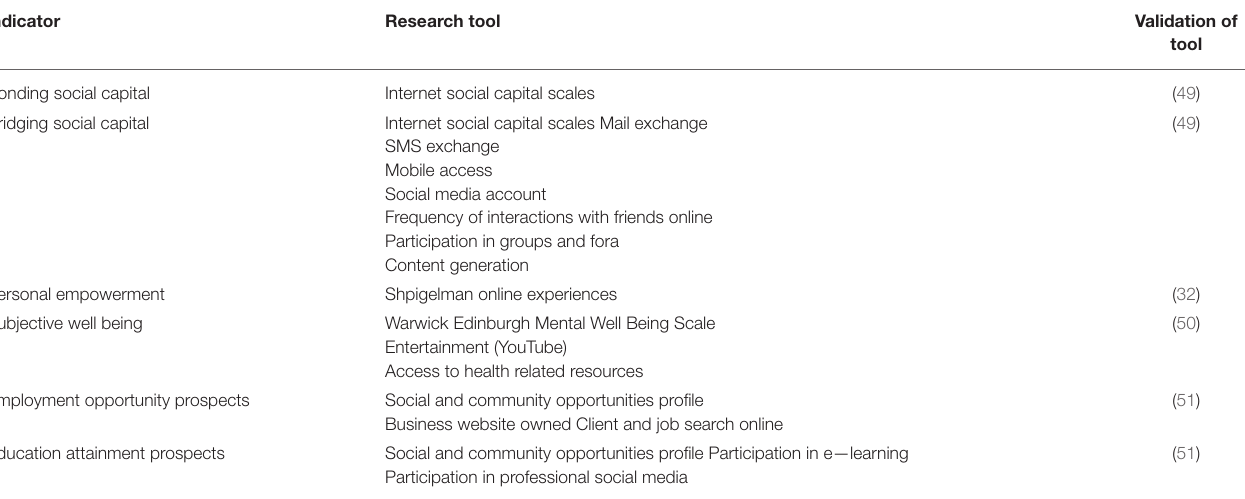
TABLE 3 | Research tools per social inclusion indicator.